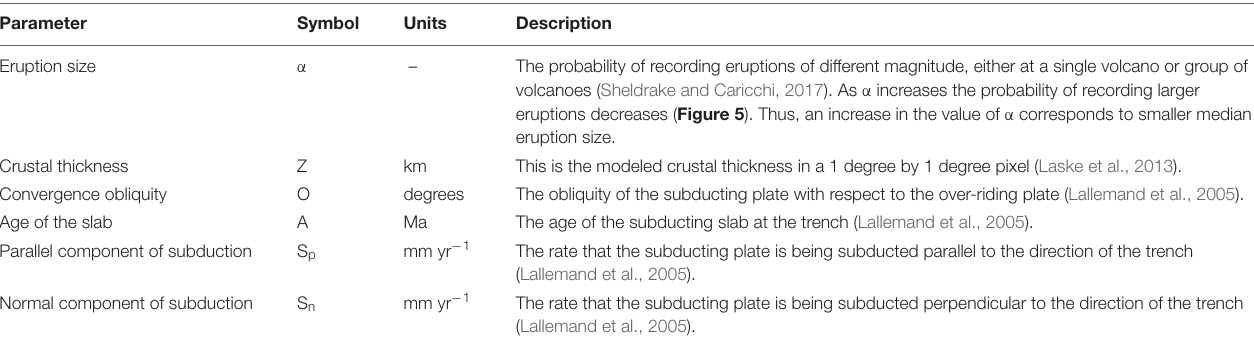
TABLE 1 | Table of all parameters using in our